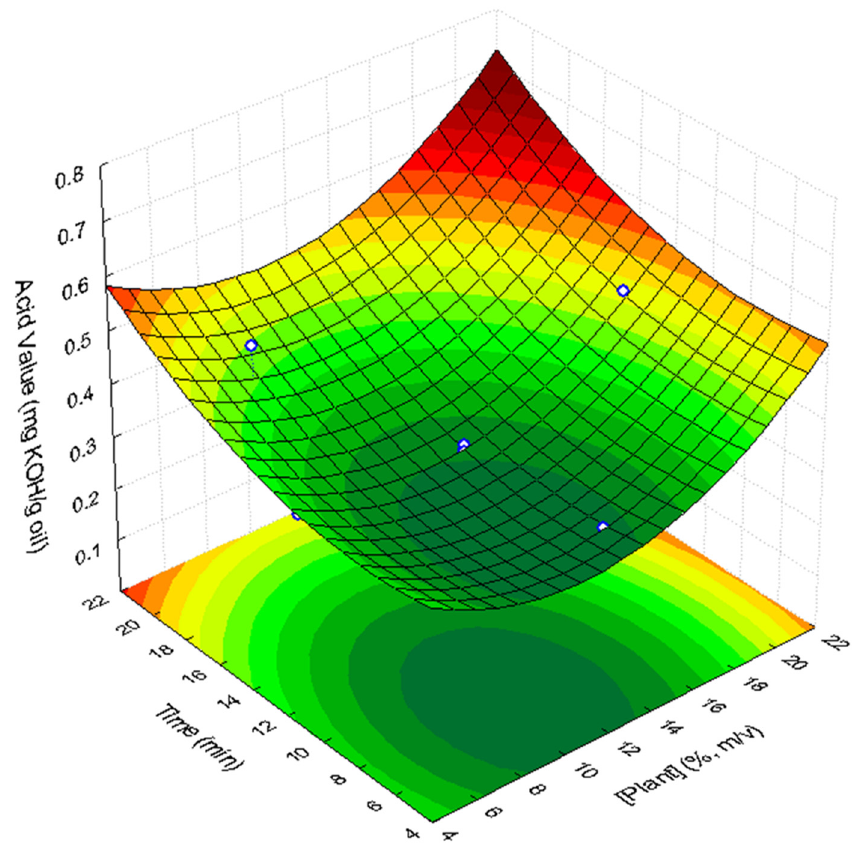
Figure 1. Response surface describing the acid value of supplemented sunflower oil with lyophilized C. maritimum extracts, as a function of lyophilized C. maritimum concentration and UAE time.